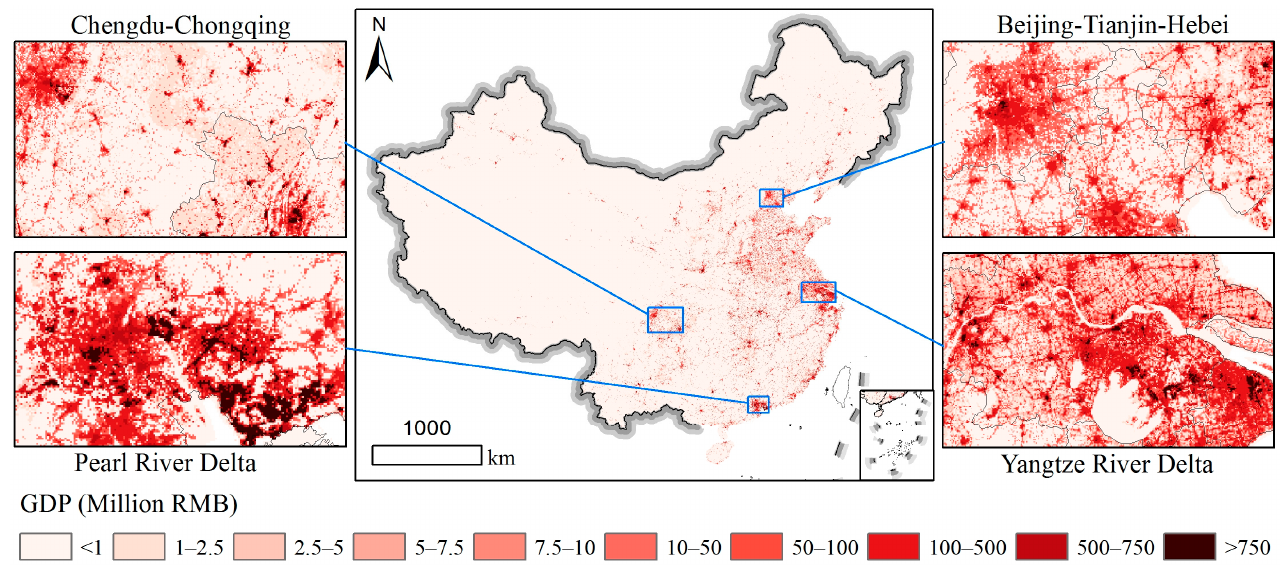
Figure 7. The 1 km gridded GDP map of China for the primary sector.